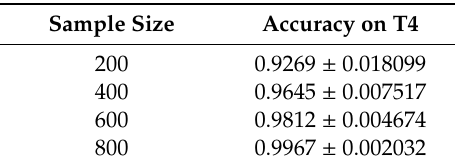
Table 3. Window size vs.